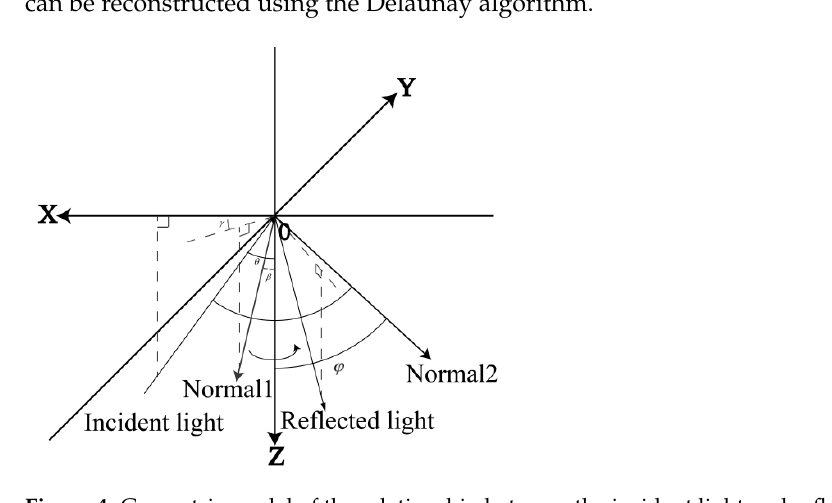
( b ) Figure 6. ( a ) Photograph and ( b ) schematic diagram of the THz raster-scan imaging system. 3.3. Implementation Details of Network Training and Image Predicting The training set includes 33,200 images gained by the translation or rotation of printed Chinese characters. The size of each of these images is 256 × 256. Each image, taken as the standard image, was converted into grayscale. The distorted image was obtained by the method set out in Section 2.3. Figure 7 shows some training image pairs from the training set.